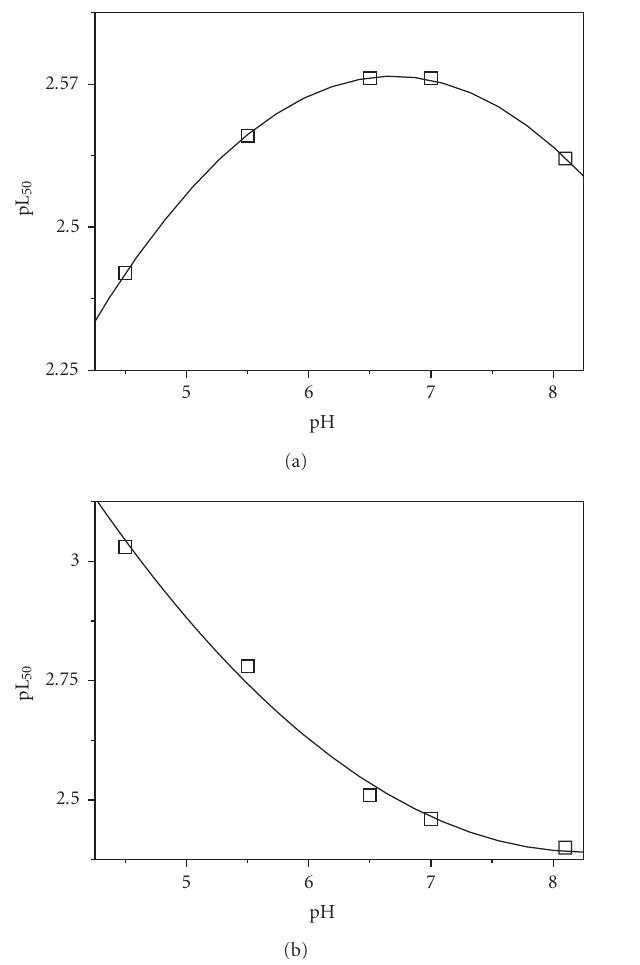
Figure 6: Dependence on pH of pL by sper (a) and lys (b) at I = 0 . 1 mol L − 1 in NaCl aq at t = 25 ◦ C.